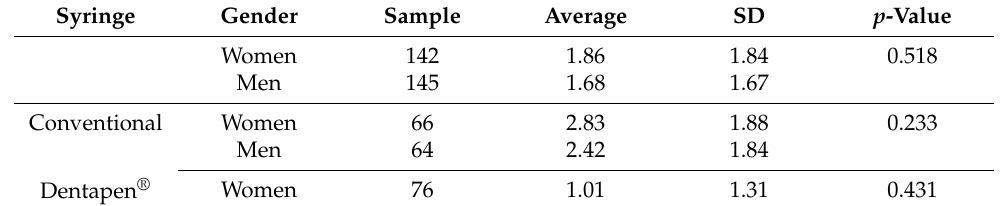
Table 5. VAS comparison and statistical significance by gender.